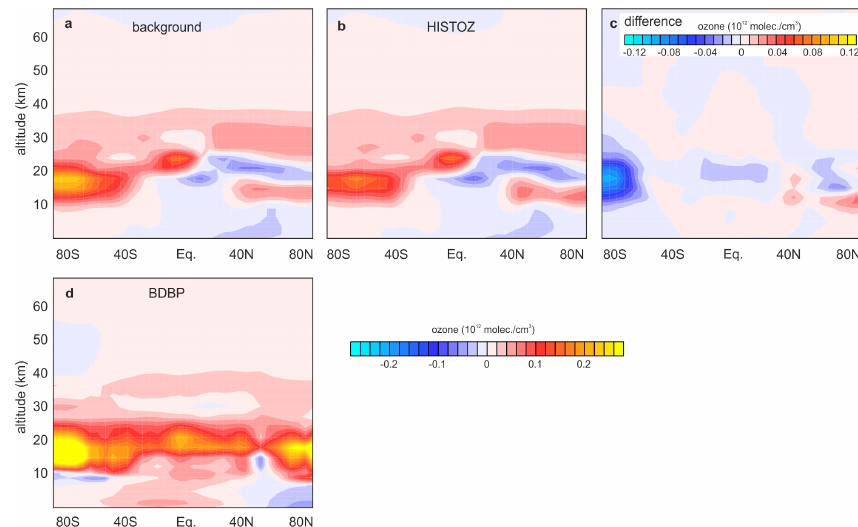
Figure 12. Zonal mean ozone differences for solar maximum minus solar minimum (see Table 4) prior to 1979 in (a) the background, (b) HISTOZ.1.0) and (c) the difference HISTOZ.1.0 minus background. Panel (d) shows corresponding differences in the post-1979 period (BDBP). Percentage deviations are shown in Fig. S10.